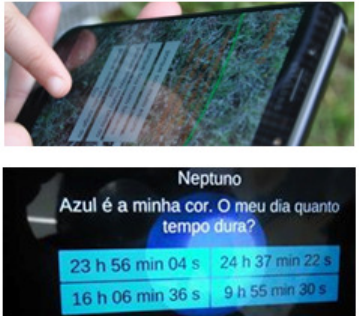
Figure 2. Neptune’s question: Blue is my color. How long does my day